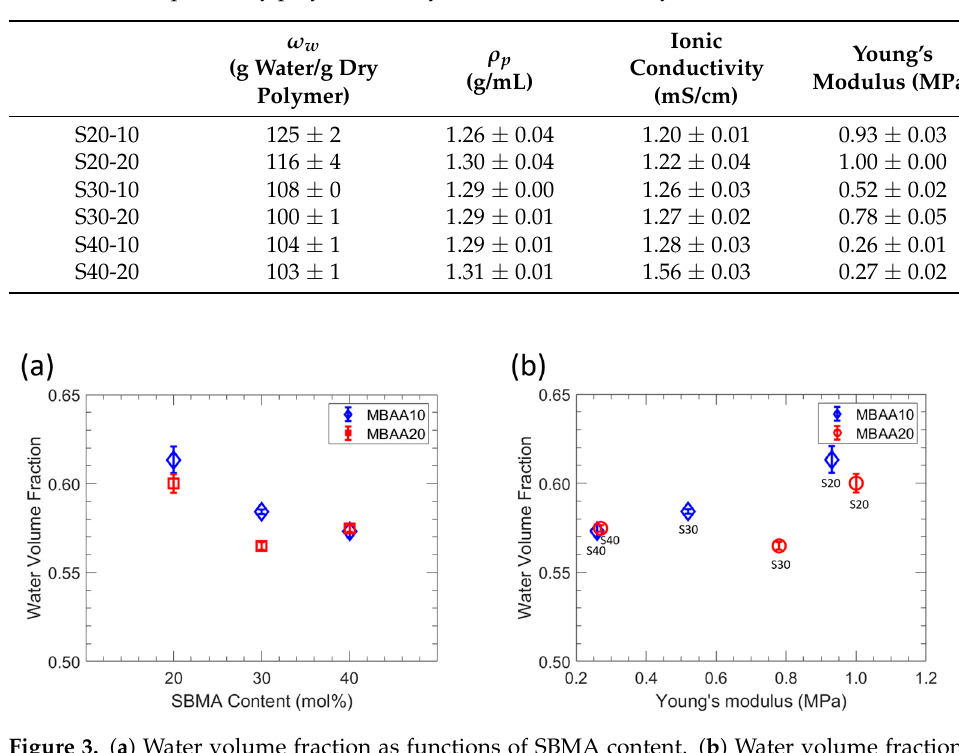
Table 2. Water uptake, dry polymer density, and ionic conductivity of all films.